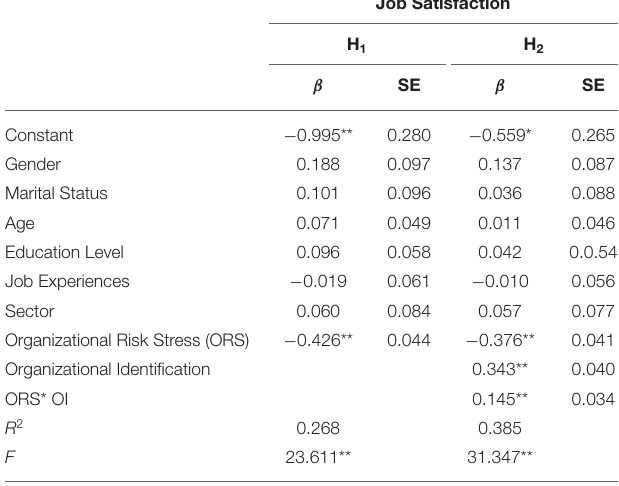
TABLE 2 | OI moderating